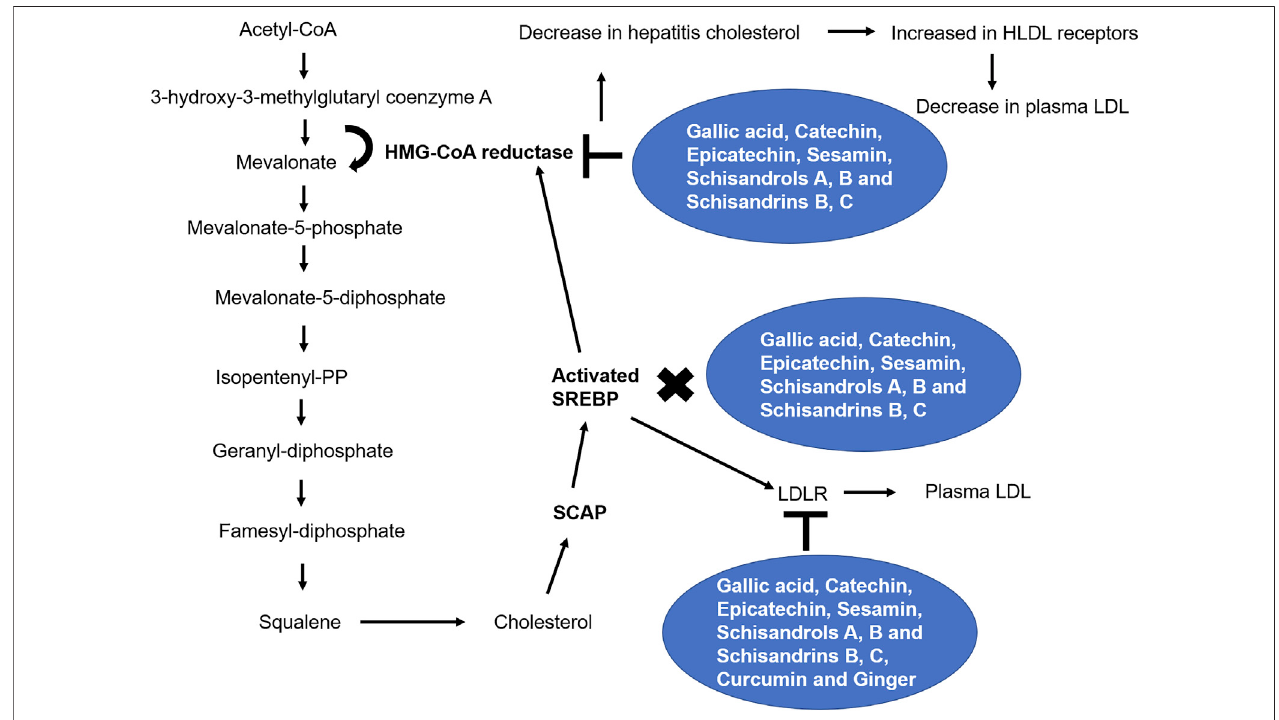
FIGURE 2 | Phytochemicals and the mevalonate pathway. Through several enzymes, glycolysis ’ end product, acetyl-CoA, is converted into cholesterol. By inhibiting the mevalonate pathway, statins and secondary metabolites are prevented from translocating to the Golgi apparatus and activating SREBPs (Göbel et al., 2020b).